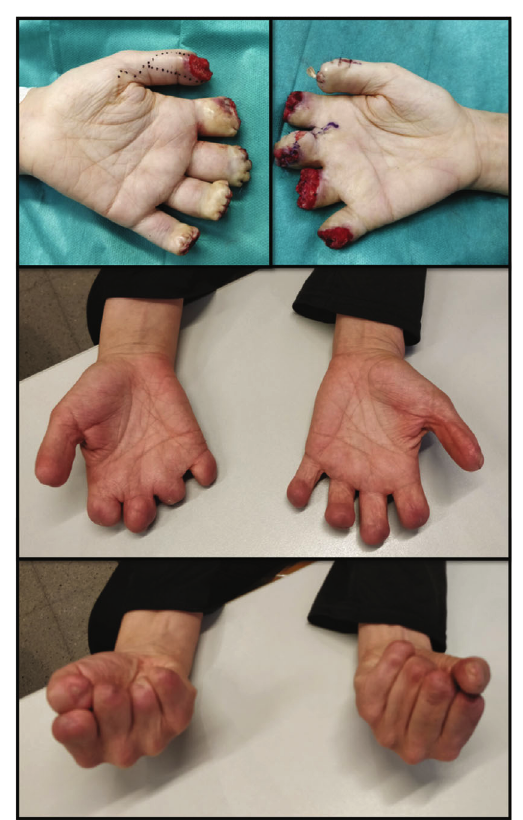
Figure 2: Intraoperative levels of amputation and functionality after complete wound